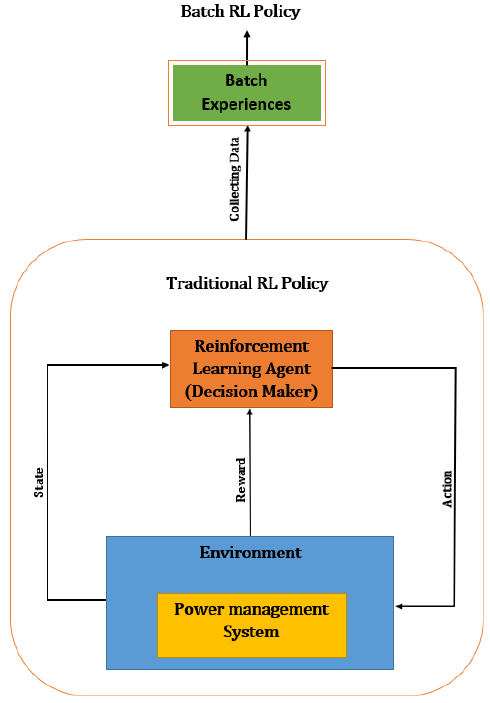
Figure 15. Batch Reinforcement Learning .